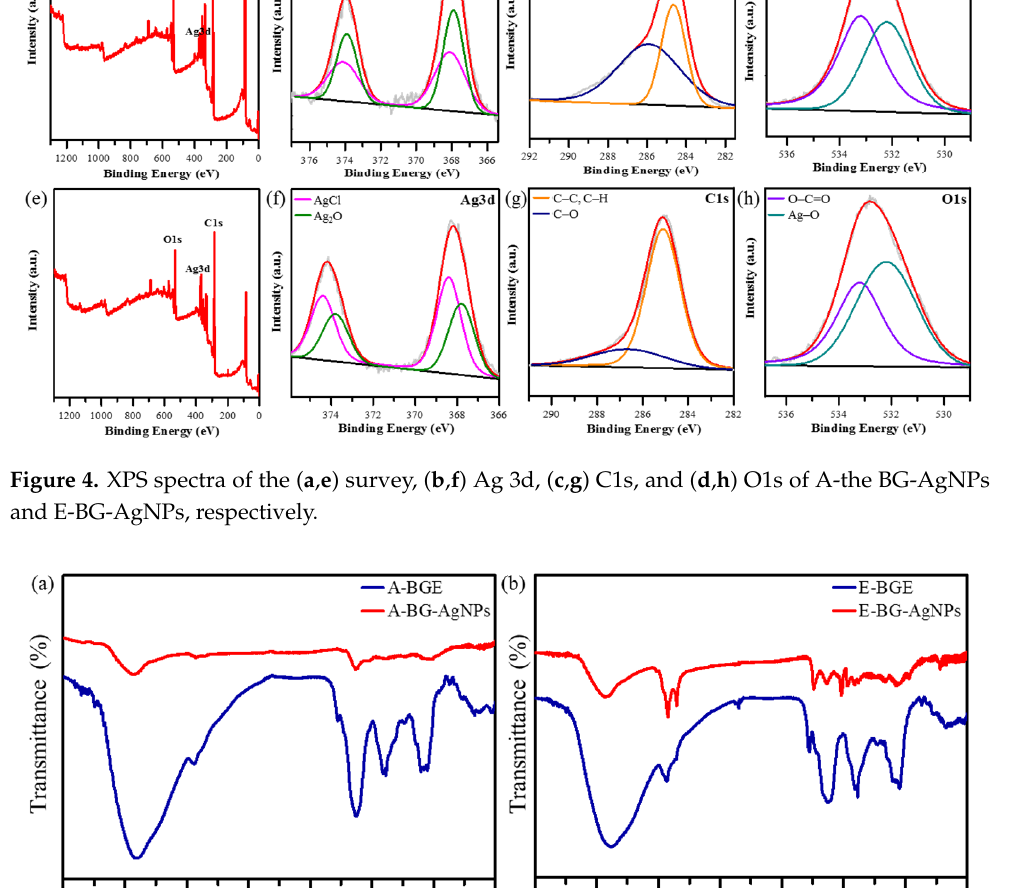
Figure 6. Images of (A) A-BG-AgNPs and (E) E-BG-AgNPs (50 µg/mL) in different media after in- cubation at the indicated time. 3.2. Quantification of Phytoconstituents and In Vitro Antioxidant Activity The TPC and TFC assays were conducted to determine the total phenolic and flavo- noid content present in the BG extracts. While using gallic acid and quercetin as the refer- ence [47], Figure 7a indicates that both the aqueous and ethanolic BG extracts possessed different degrees of phenolic and flavonoid contents. We noticed that A-BGE had a higher phenolic content of 10.2 mg GAE/g compared to E-BGE (7.7 GAE/g). Interestingly, the TFC results showed less flavonoid content in A-BGE (0.7 mg QE/g) than in E-BGE (6.1 mg QE/g).